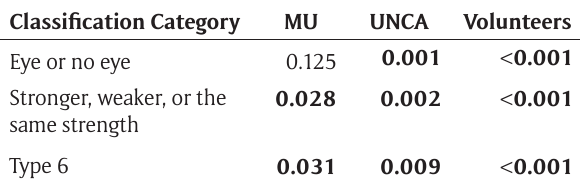
Table 2: Shapiro – Wilk test for normality for the three test categories. Values below 0.05 mean that normality of the distribution can be rejected at the 95% confi-